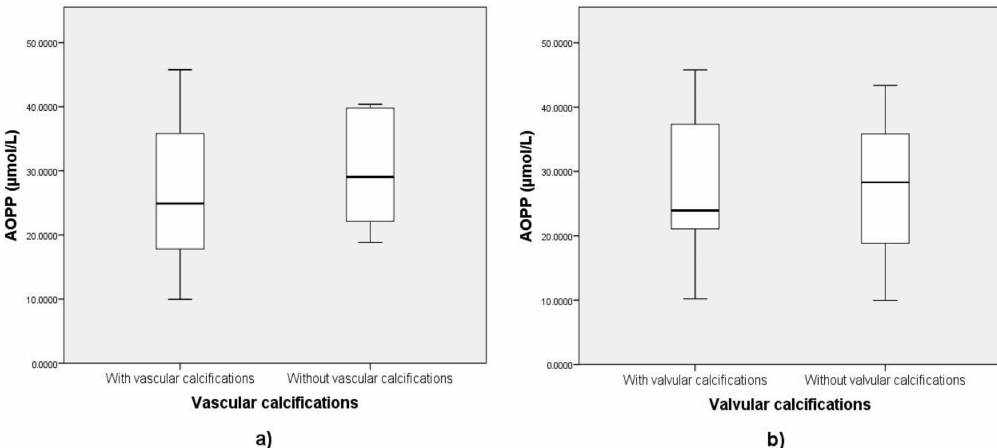
Figure 2. Differences in AOPP values between patients with and without vascular calcifications visible on ( a ) pelvic and hand radiographs and ( b ) cardiac ultrasound. Legend: AOPP = advanced oxidation protein